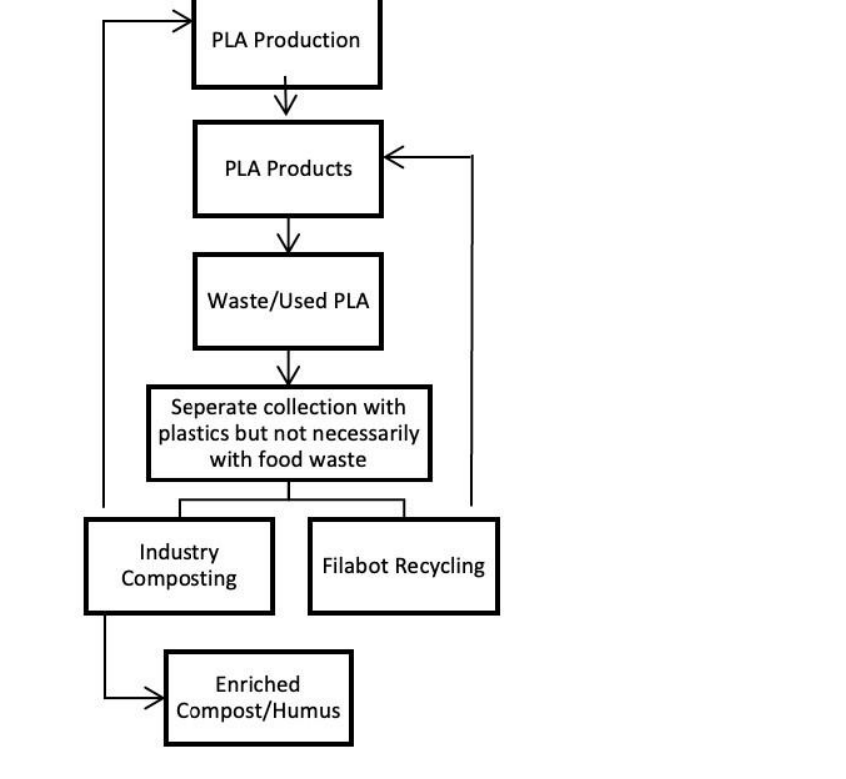
Figure 16. Waste management process of PLA. Adapted from “Bioplastics: A boon or bane?” , Re- newable and Sustainable Energy Reviews, vol. 147. Elsevier Ltd., Sep. 01, 2021. Doi: 10.1016/j.rser.2021.111237 [31].